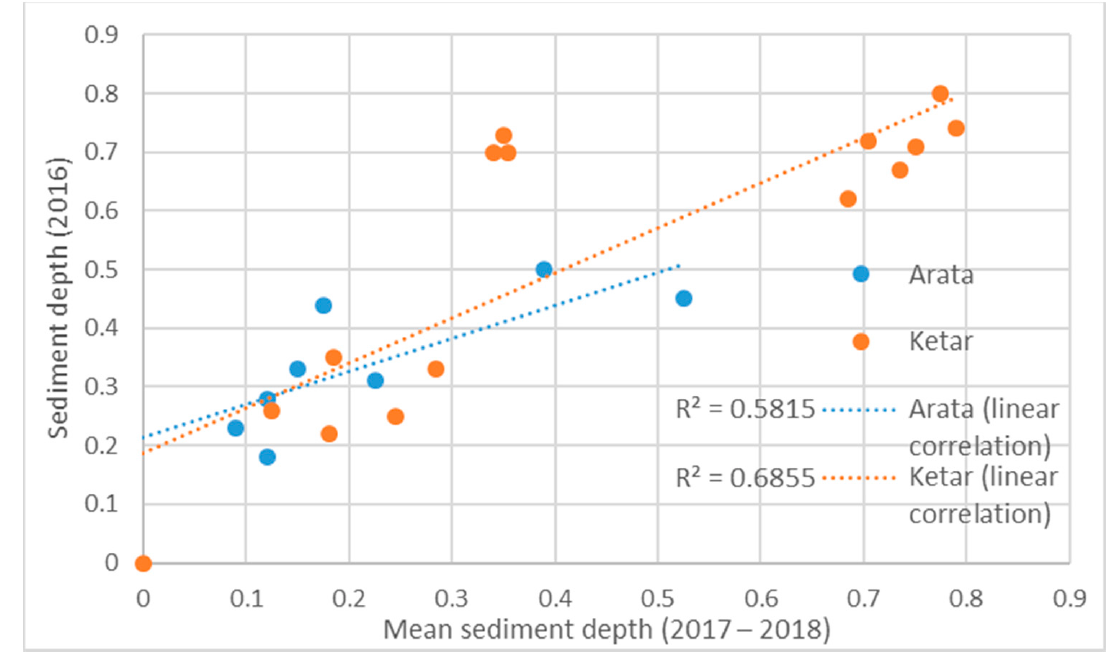
Figure 11. Correlation between the mean of the sediment volumes in 2017 and 2018 and the sediment volume estimated for 2016 using flood and sediment marks with farmer participation.